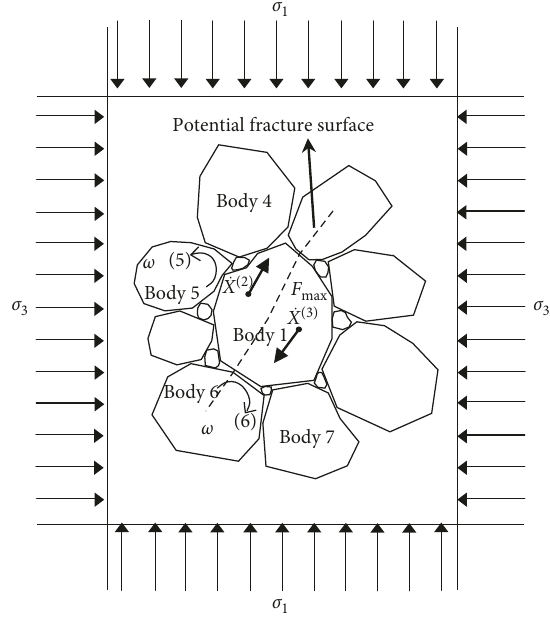
Figure 2: Mechanics mechanism of particle